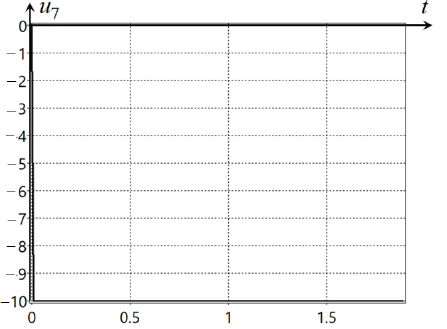
Figure A13. Plot of optimal values of control component u 7